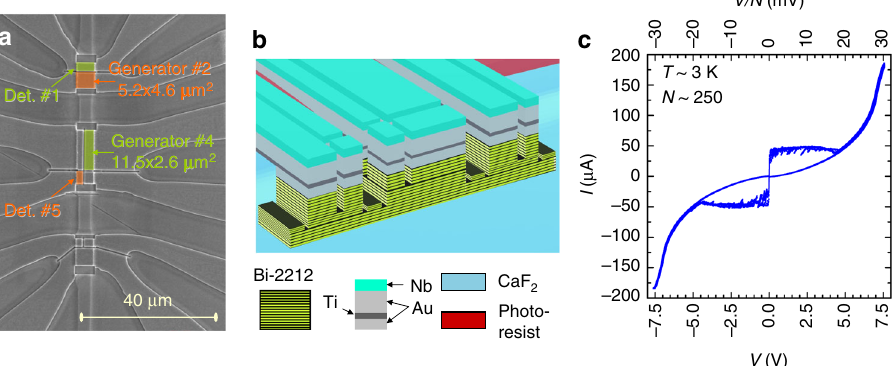
Fig. 1 Sample characteristics. a Scanning electron microscopy image of the studied sample. The generator and the detector mesas are indicated. b A three- dimensional sketch of the sample. c Current – voltage characteristics of the generator mesa #2. The top axis shows voltage per junction. A kink at V = N ¼ 2 Δ = e ’ 30 mV represents the sum-gap singularity. It corresponds to ~15 THz upper Josephson frequency